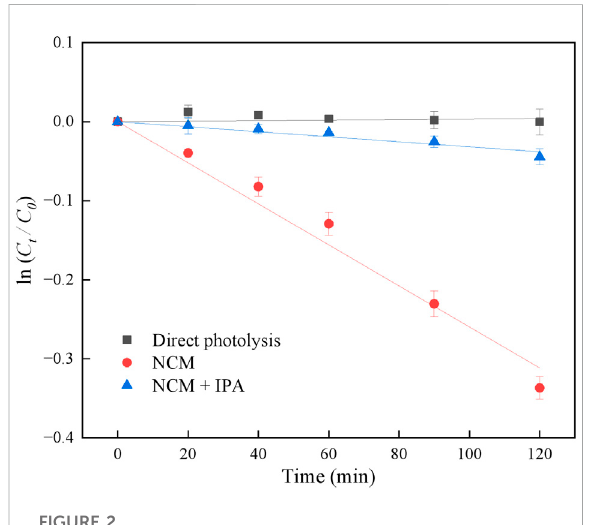
FIGURE 2 Photolysis effect of acid orange 8 in three different